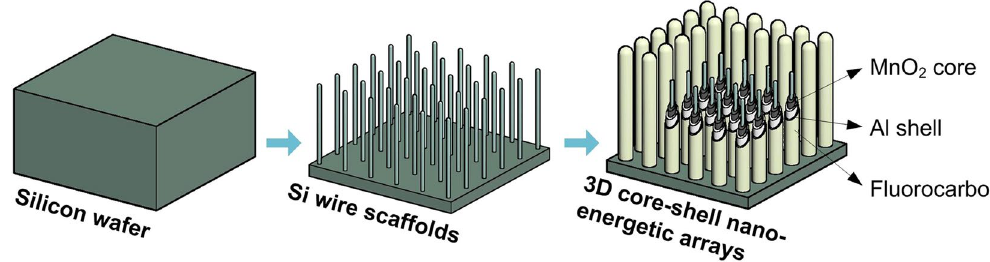
Figure 1. Schematic illustration of the fabrication process of the 3D silicon wire supported MnO 2 /Al/ fluorocarbon nanoenergetic